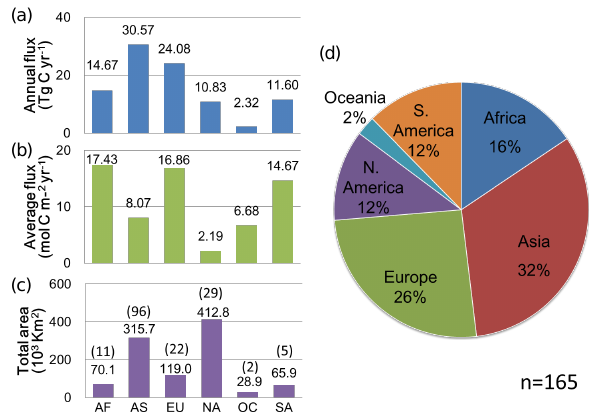
1 Fig. 6. Annual CO 2 flux (a) , average CO 2 flux per unit area (b) , total Figure 6. Annual CO 2 flux (a), average CO 2 flux per unit area (b), total surface area (c), and percentage of 2 surface area (c) , and percentage of total CO 2 flux (d) from estuaries total CO 2 flux (d) from estuaries in each continent. Numbers in parentheses indicate the number of 3 in each continent. Numbers in parentheses indicate the number of estuaries studied. 4 5 estuaries studied.